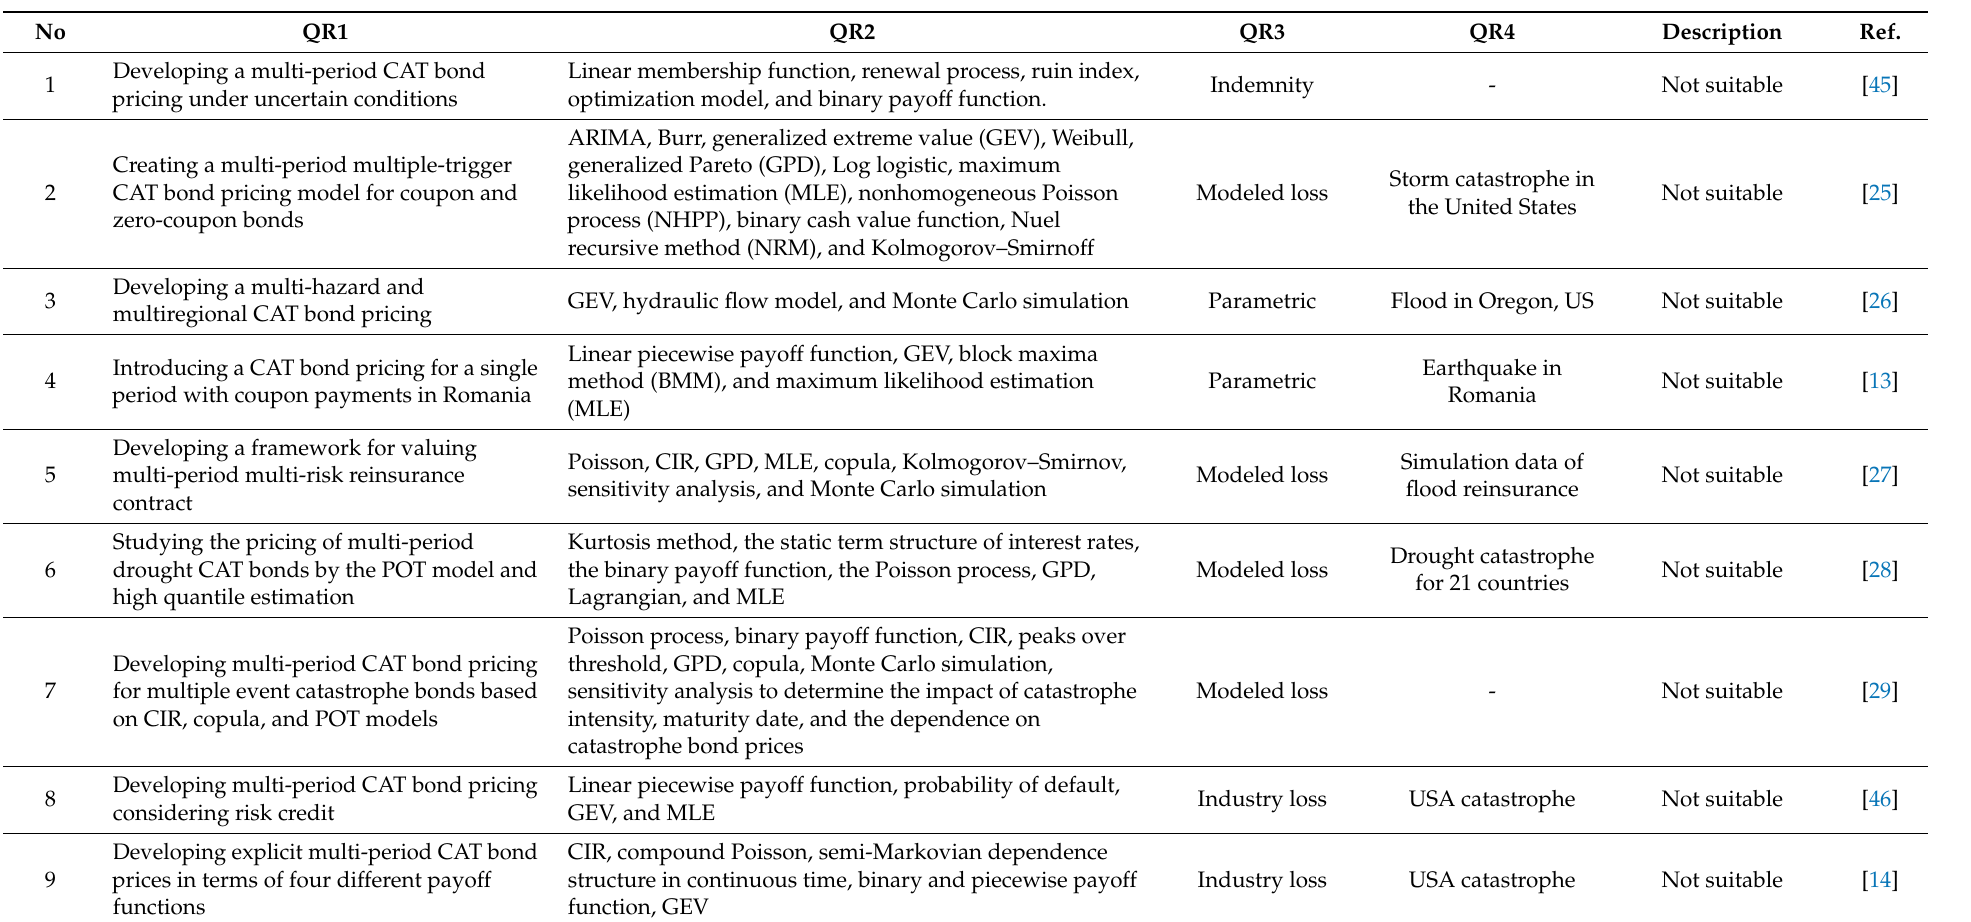
Table 4. The summary of 23 articles based on accessibility and the relevance of their full text and